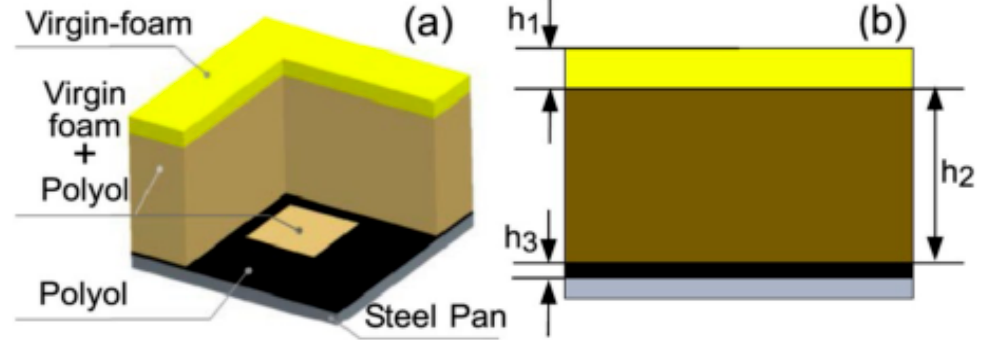
Figure 3. The model’s schematic: ( a ) fuel content within the layer; ( b ) layer thickness of the layer [46].